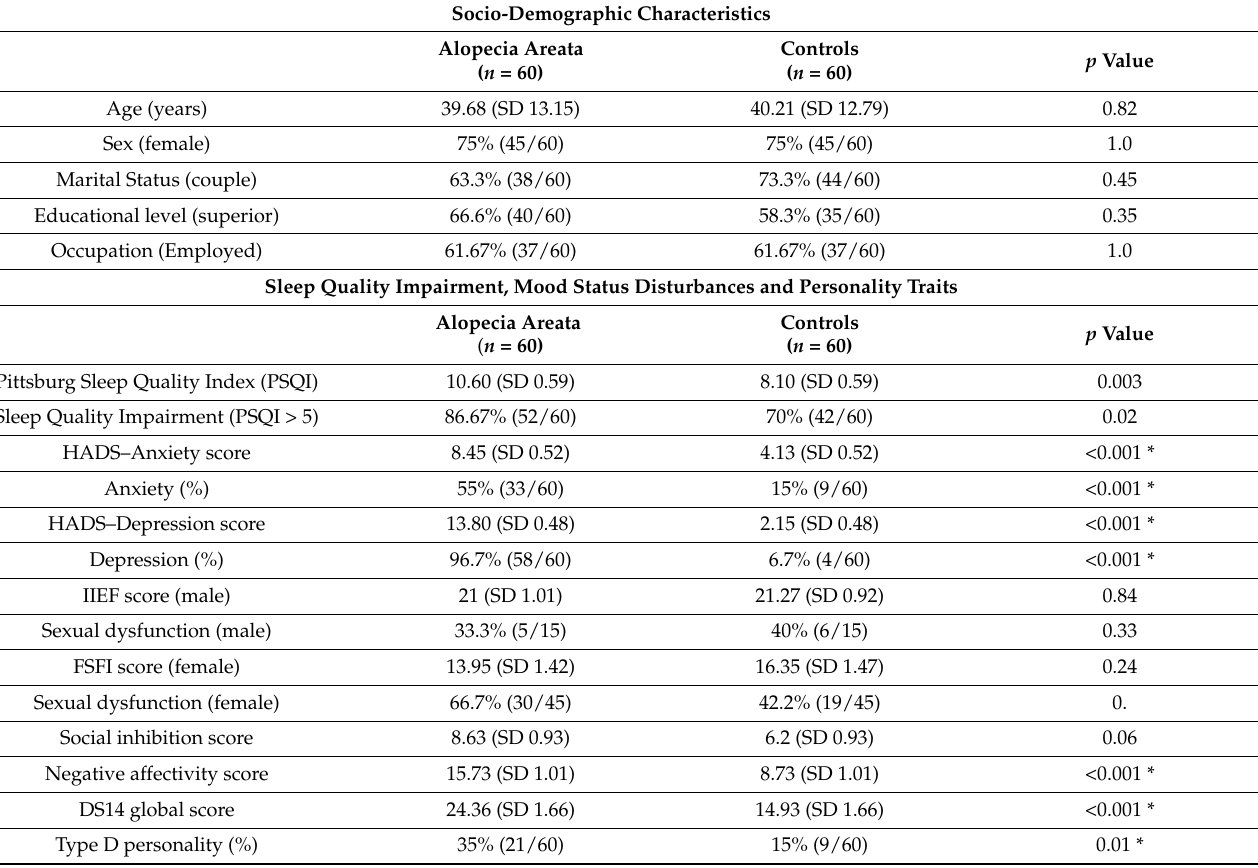
Table 2. Comparative socio-demographic characteristics, mood disturbances, sexuality and personal- ity measurements of the participants.